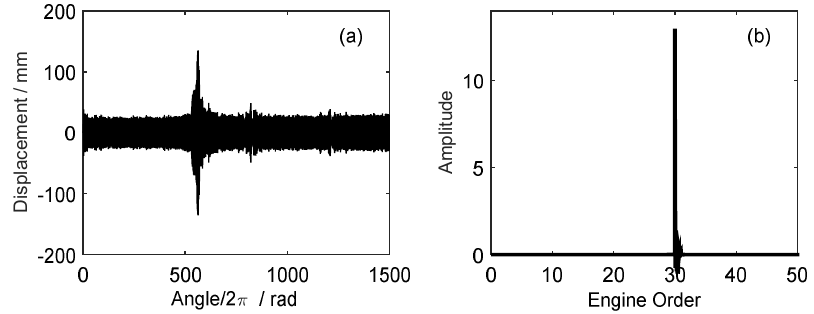
Figure 20. ( a ) The angular-domain reconstruction signal and ( b ) its order spectrum of the 24th blade.